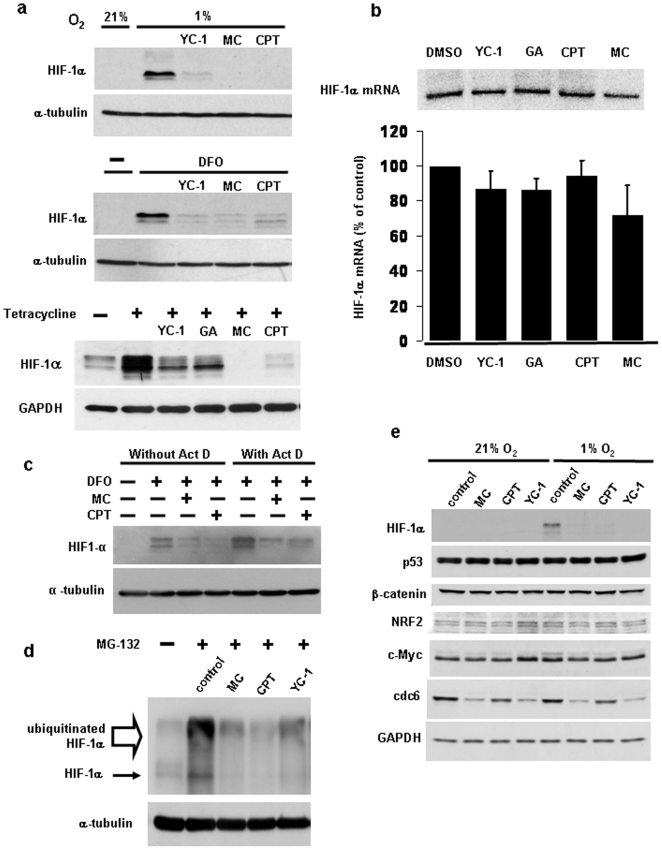
The effect of the mitomycin C, camptothecin and YC-1 is due to inhibition of HIF-1α protein synthesis.(a–b) HEK293 cells were incubated for 10 hours in the presence of YC-1 (50 µM), mitomycin C (10 µg/ml), camptothecin (2 µM), and geldanamycin (10 µM) and cell lysates subjected to Western blotting using the indicated antibodies. Cells were incubated at 1% oxygen during the last three hours of inhibitor treatment (upper panel) or in the presence of 200 µM desferrioxamine (DFO) during the inhibitor treatment for 10 hours (middle panel), as indicated. In the bottom panel, stably transfected cells with tetracycline inducible expression of dnUbc12 (5) were treated with 1 µg/ml tetracycline to block VHL mediated HIF-1α degradation for 9 hours and cotreated with the indicated drugs for the last 5 hours, followed by Western blotting. The presence of drugs during the induction time is indicated. (b) HIF-1α mRNA concentrations after inhibitor treatment for 10 to 12 hours were measured as described under Material and Methods. A representative autoradiogram is shown in the top panel. The bottom panel shows the average mRNA levels for each inhibitor treatment expressed relative to those of DMSO control, as determined by densitometry of autoradiograms obtained from three independent experiments. Statistical analysis using one-way ANOVA test across all treatment groups showed that all inhibitors exerted an insignificant (p>0.05, n = 3) effect. (c) Cells were treated with 200 µM desferrioxamine and the indicated drugs in the absence or presence of 5 µM actinomycin D for 8 hours, followed by Western blotting. (d) HIF-1α protein accumulation was measured by Western blotting after cotreatment of cells with 25 µM MG-132 (added to cells for the last 4 hours) and the various inhibitors as indicated (added to cells for the last 9 hours). (e) To confirm the specificity of the effect of mitomycin C, YC-1 and camptothecin, Western blotting for the indicated proteins was carried out after drug treatment of cells for 11 hours and incubation at 1% oxygen during the last 4 hours, as indicated. Inhibitor concentrations in (b–e) were as in (a).